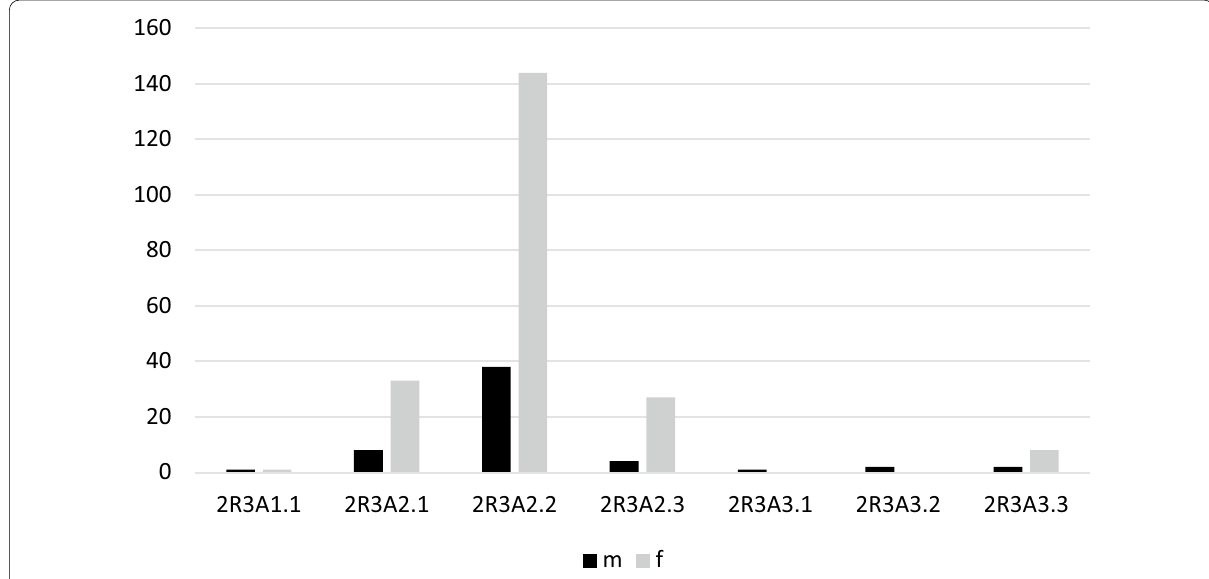
Fig. 6 Distribution of extraarticular patterns of DRFs according to gender. M, male; F, female; DRFs, distal radius fractures